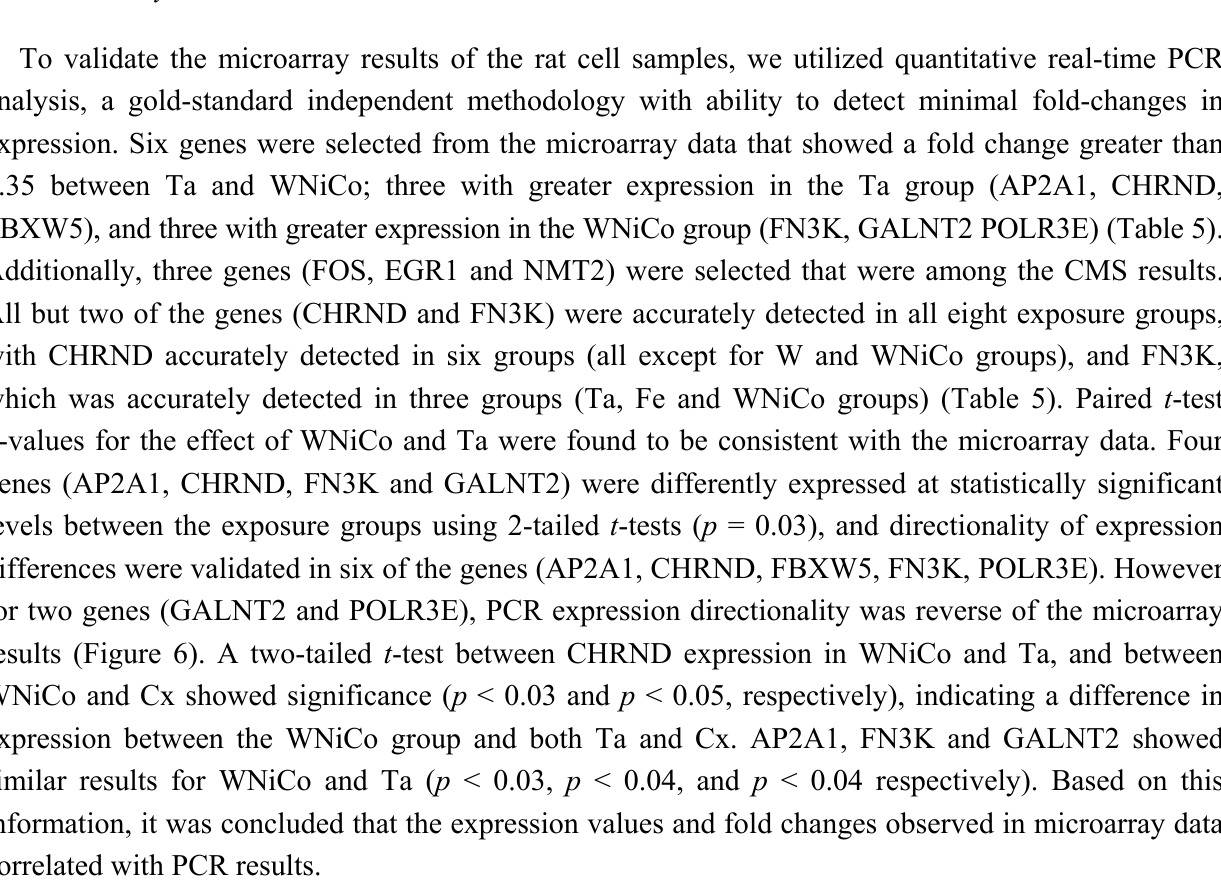
Table 5. Genes selected for PCR validation, with rat microarray average signal values.